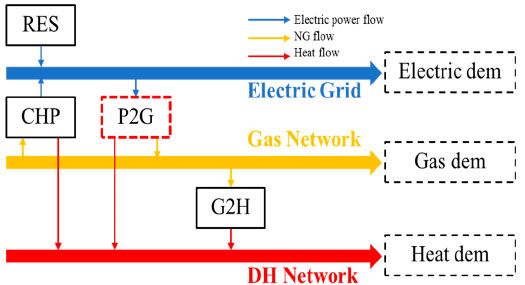
Figure 1. Representation of a multicarrier energy system and the energy conversion technologies that act as network connectors.